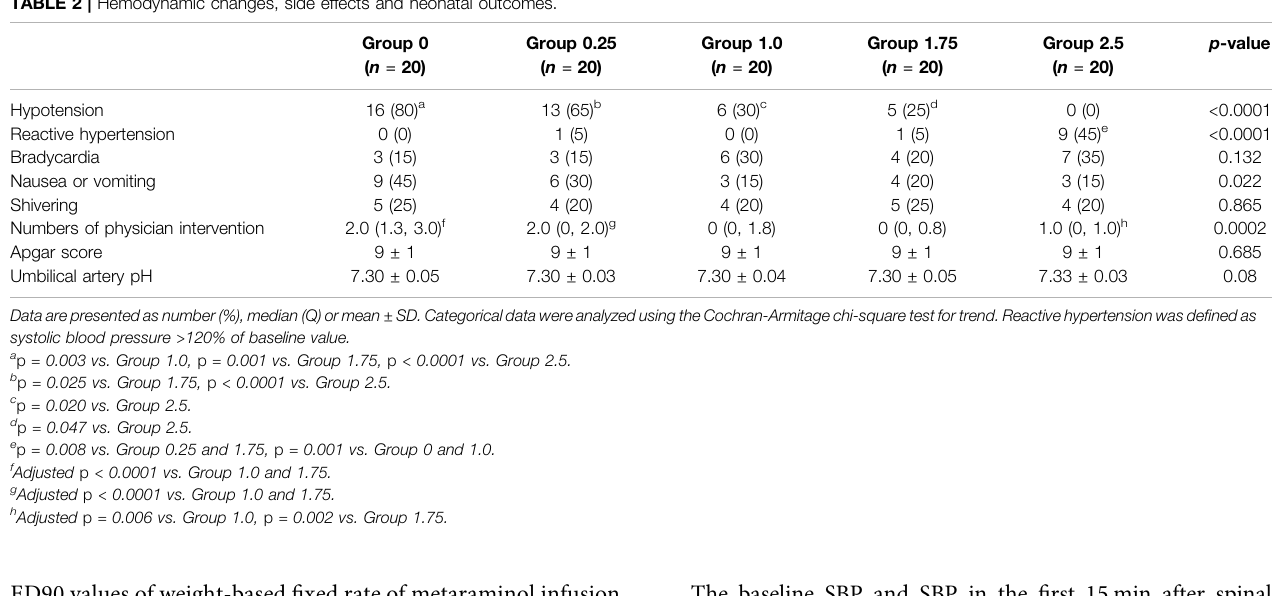
TABLE 2 | Hemodynamic changes, side effects and neonatal